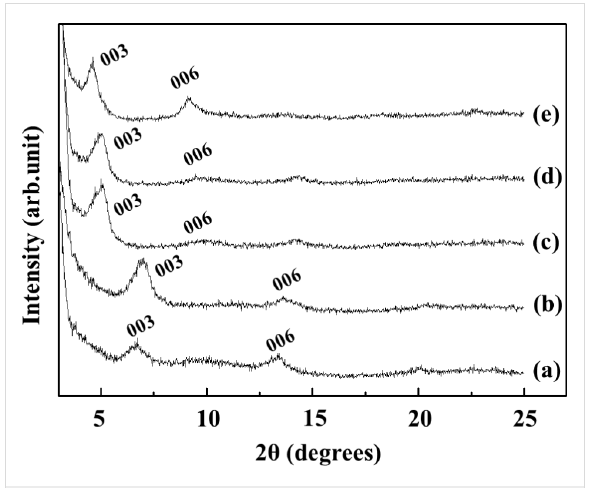
Figure 2: X-ray diffraction (XRD) patterns of GMP/LDH (GL) hybrid under controlled reaction temperature with GMP/LDH 1:2 for 1